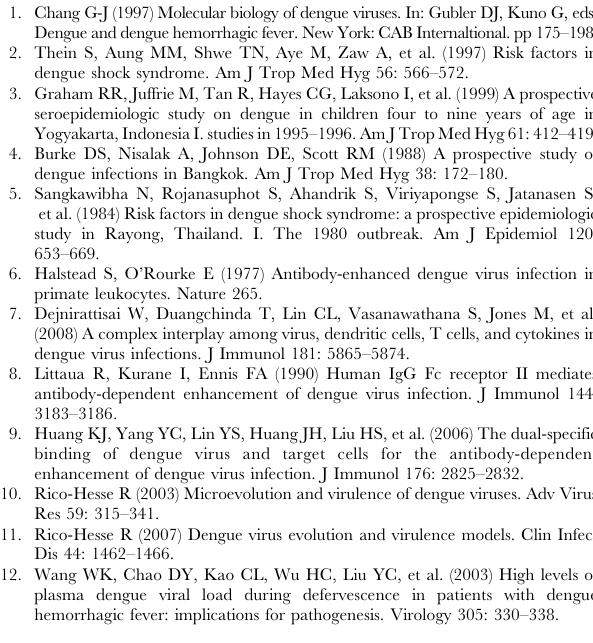
Table S1 The characteristics of the study population by serotype. Table S2 Levels of viremia among the study population by illness day and serotype. Table S3 Peak viremia analysis. Table S4 Maximum of hemoconcentration, platelet and WBC nadirs and their occurrence times by disease severity. All these markers were determined in serial plasma samples from DENV-1 infected patients with primary DF (n=